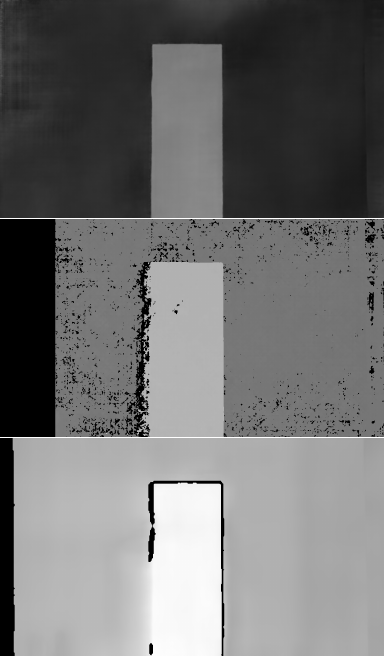
Figure 3. Depth maps of edge scene using (a) DispNet, (b) SGBM and (c) stereolabs.